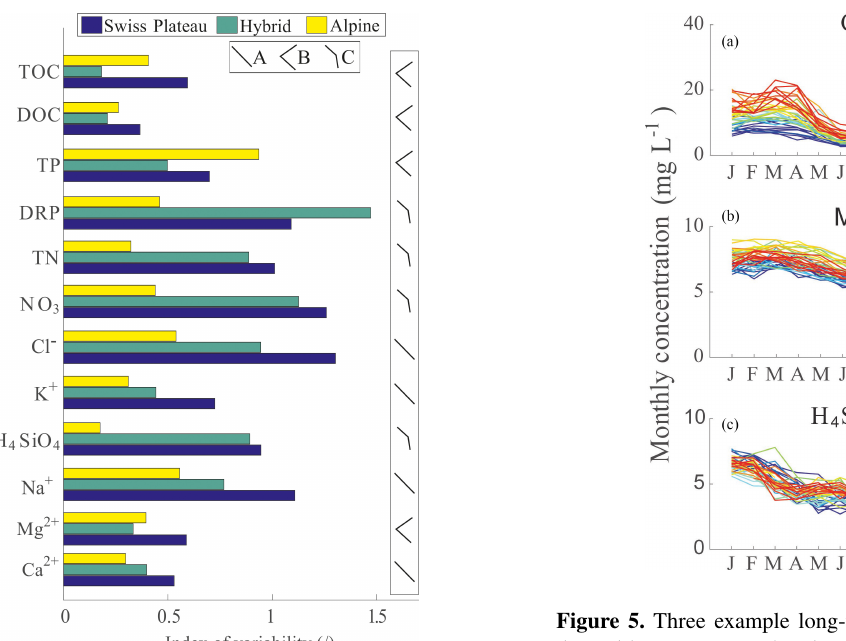
Figure 5. Three example long-term patterns of solute concentra- tions. (a) represents a clear increasing trend, (b) a non-monotonic trend (firstly increasing and then decreasing), and (c) shows the ab- sence of any trend. The patterns are shown for the station of Aare – Brugg as an example case.